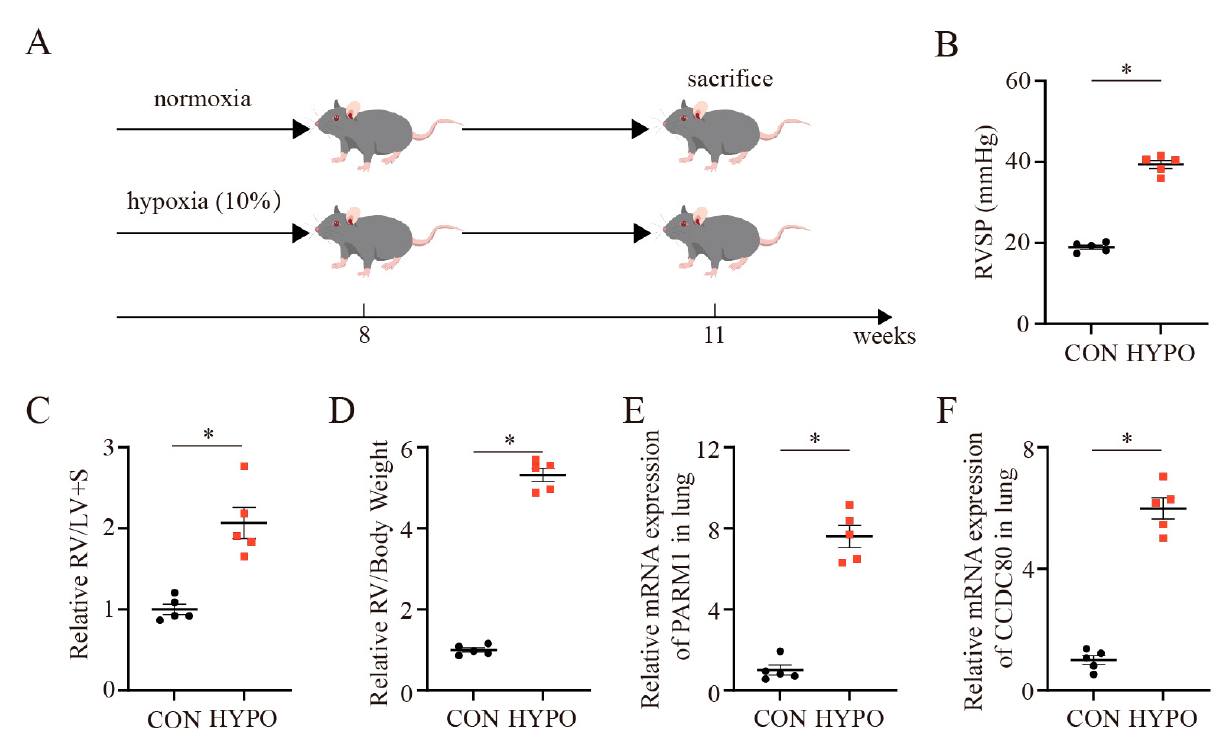
Figure 5. Establishment of pulmonary arterial hypertension mouse model. ( A ) Schematic illustration of pulmonary arterial hypertension mouse model. ( B – D ) RVSP, RV/(LV + S), and RV/body weight at 3 weeks after chronic hypoxia exposure (n = 5 each). ( E , F ) Relative mRNA expression of PARM1 and CCDC80 normalized to a β -actin internal control (n = 5 each). Data are shown as mean ± SEM. * p < 0.05 vs. CON group (student’s t -test). CON, control mice without pulmonary arterial hypertension; HYPO, hypoxia; RVSP, right ventricle systolic pressure; RV, right ventricle; LV, left ventricle. S, septum.